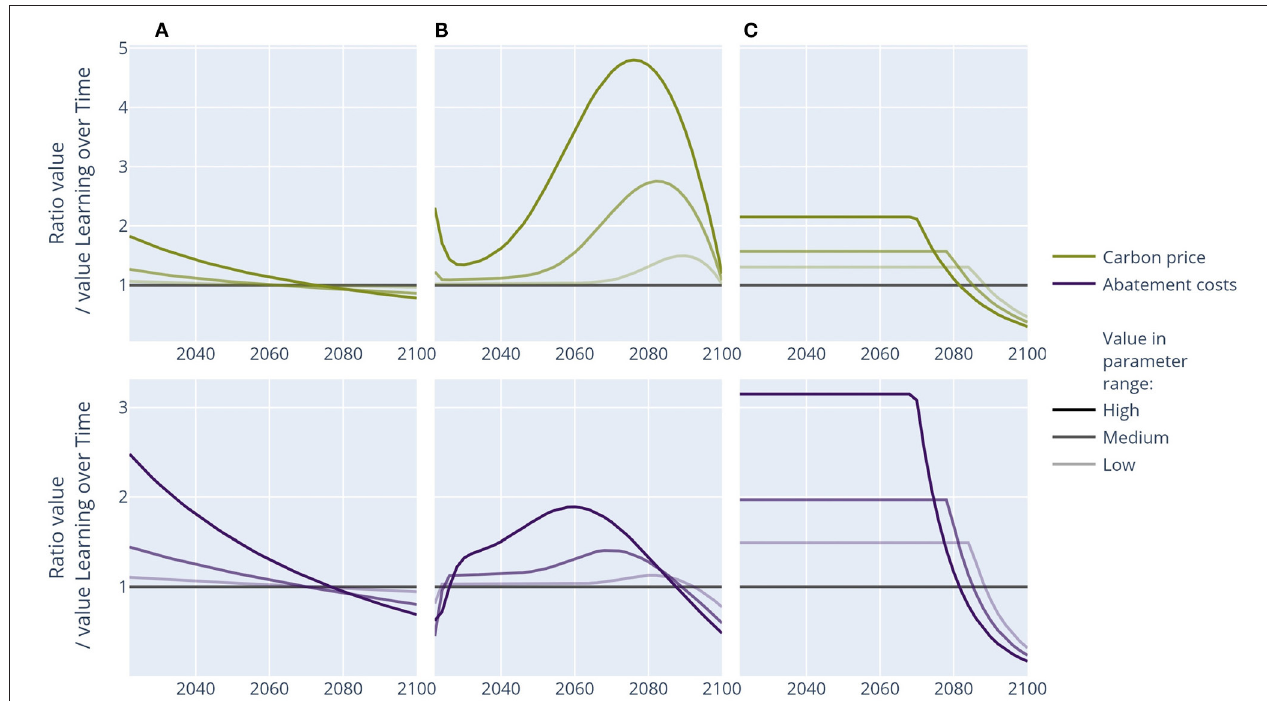
FIGURE 4 | Carbon price pathways and abatement costs of the parameter sensitivity runs relative to the learning over time pathway. Parameter values: (A) Learning by doing: rho = 0.65, 0.82, and 0.95. (B) Socio-economic inertia: 3, 5.5, and 8% of 2015 emissions. (C) Minimum emission level: 0, − 10, and − 20 GtCO 2